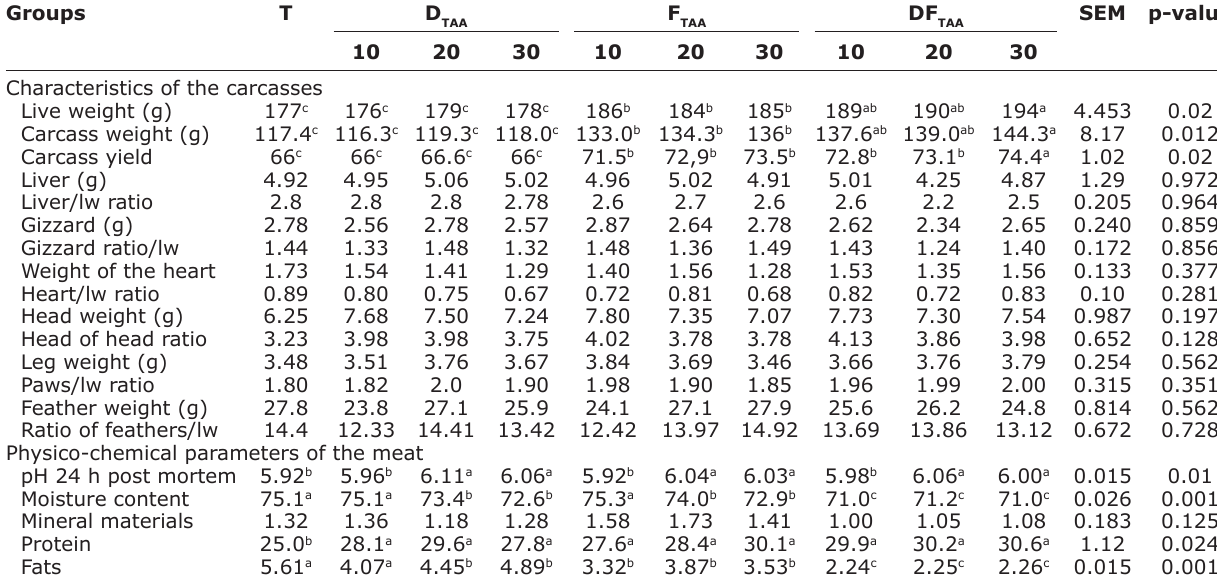
Table-6: Effects of substitution of soybean meal by apricot kernel meal on carcass characteristics and physicochemical parameters of quail meat. Groups T D TAA